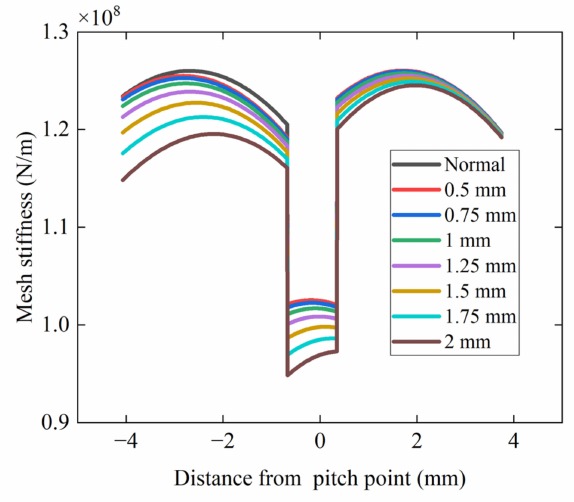
Figure 5. Time-varying meshing stiffness of gear under different crack